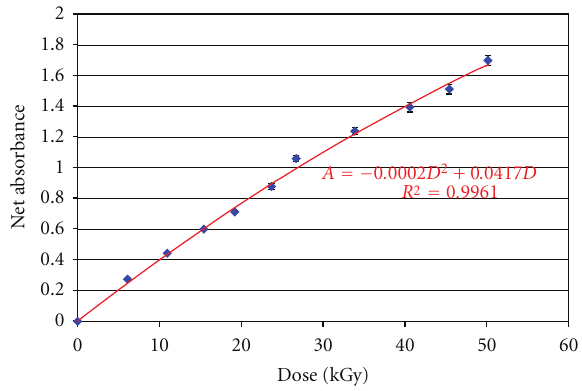
Figure 1: Dose-response curve for a liquid radiochromic dye solu- tion calibrated with alanine pellets as described in the experimental section of this work. Trendline regression was obtained with r 2 = 0 . 9961 and a maximum uncertainty of 1.52% with a coverage factor of